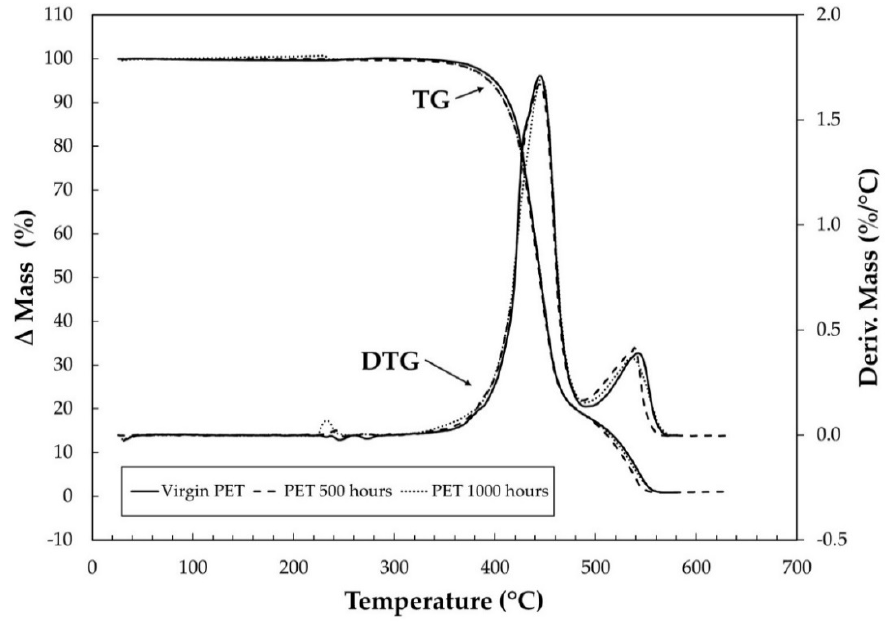
Figure 4. TG/DTG curves of virgin PET, PET 500 h, and PET 1000 h under heating rates of 20 °C·min − 1 under synthetic air purge gas with flow of 100 mL min − 1 in α -alumina crucible and sample masses around 3 mg.